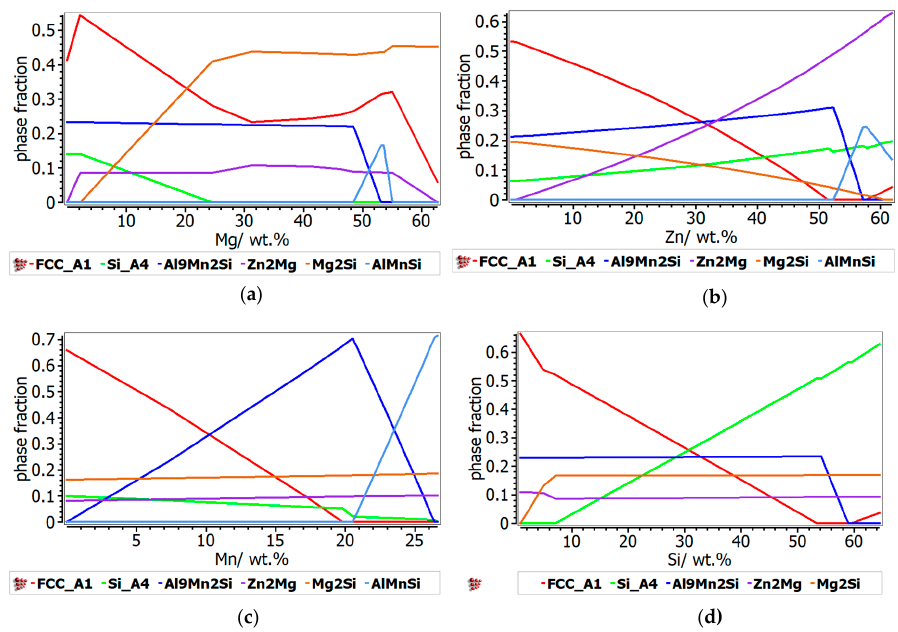
Figure 7. Influence of the element content over the phase stability in Al 3 Mn 0.2 Zn 0.3 Mg 0.7 Si 0.8 : ( a ) Mg influence; ( b ) Zn influence; ( c ) Mn influence; ( d ) Si influence.